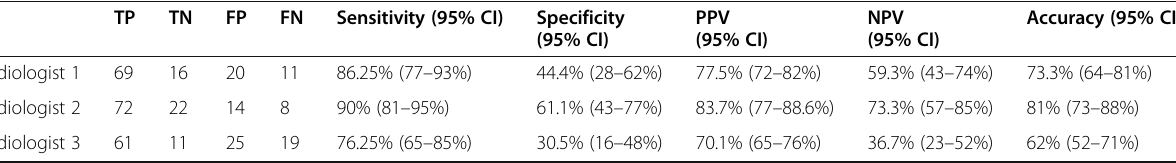
Table 4 Performance results of the three radiologists for differentiation between COVID-19 and non-COVID-19 viral pneumonias TP